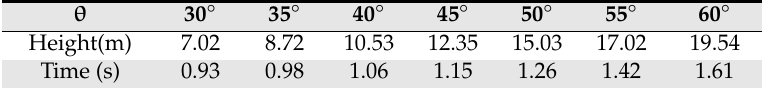
( d ) Figure 11. Flow chart of the recovery process. ( a ) Step 1. ( b ) Step 2. ( c ) Step 3. ( d ) Step 4. Table 2. The test results of the ejection mechanism.